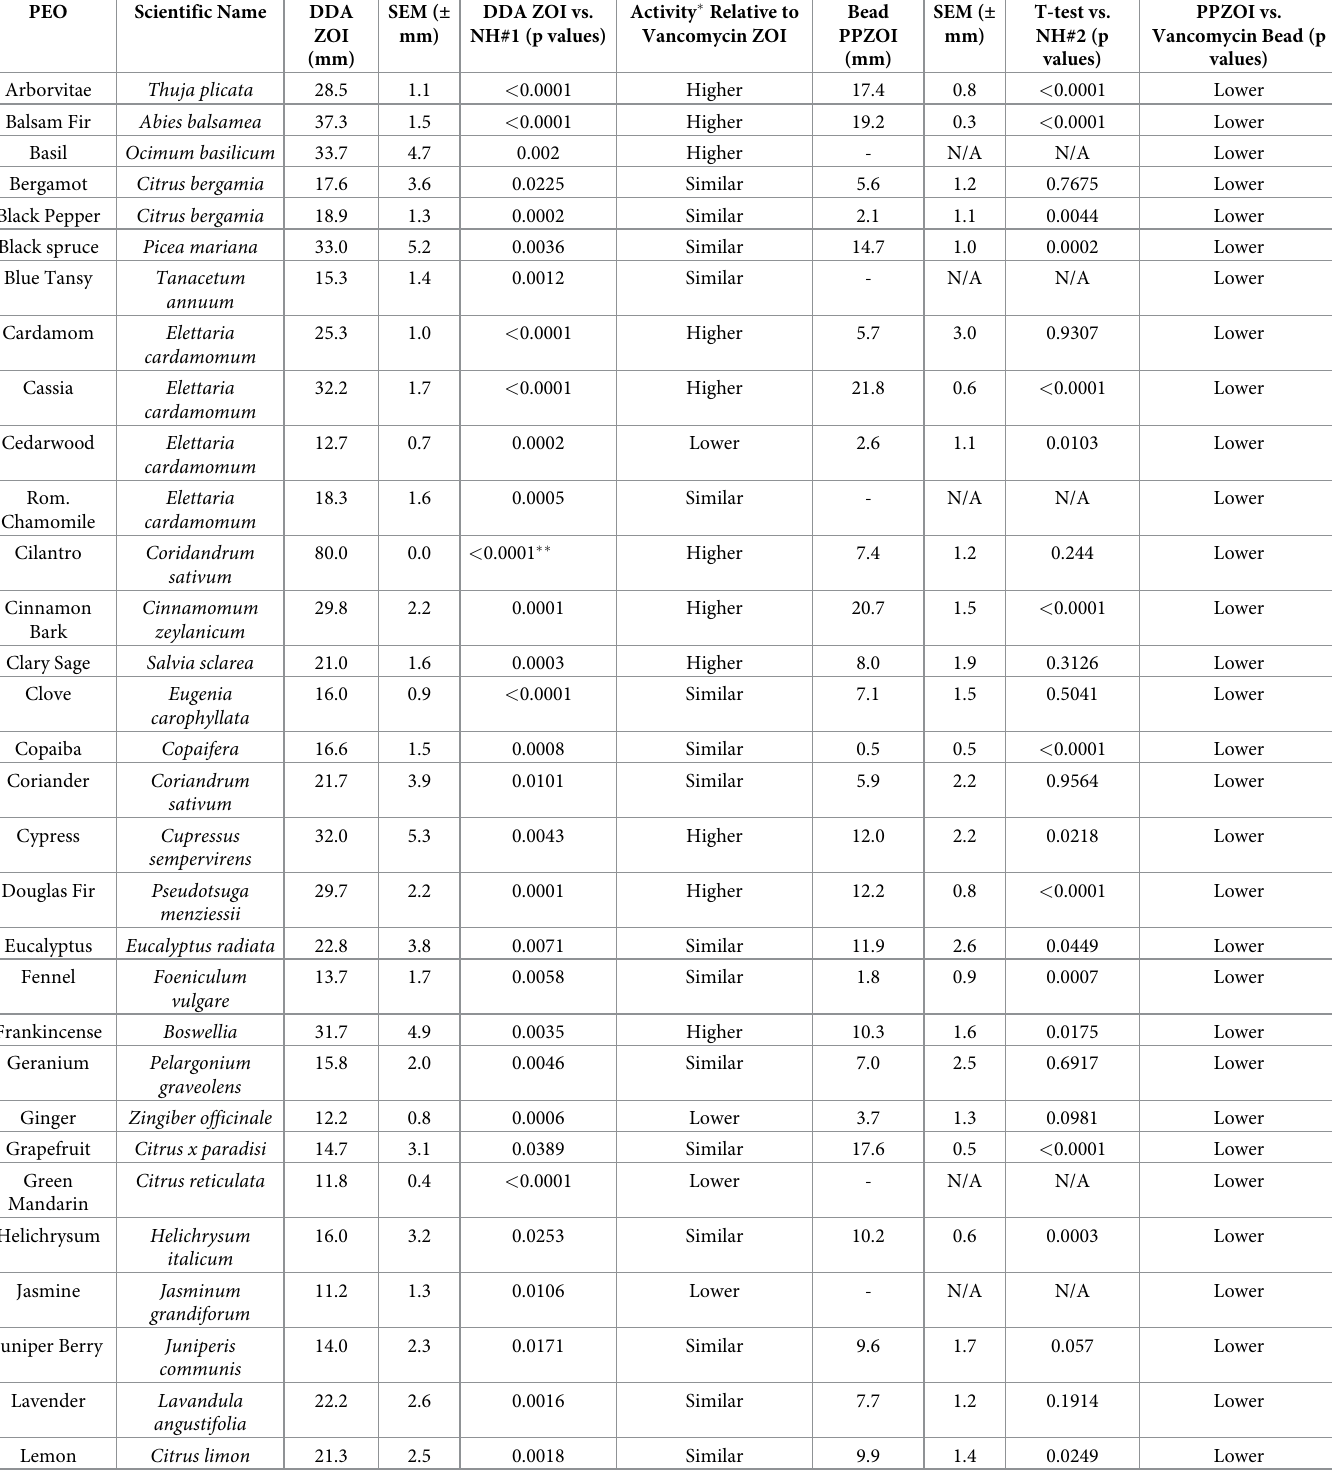
Table 1. Average growth inhibition ZOIs and one sample T tests for all PEOs tested in disk diffusion (DDA) and pour plate bead assays.